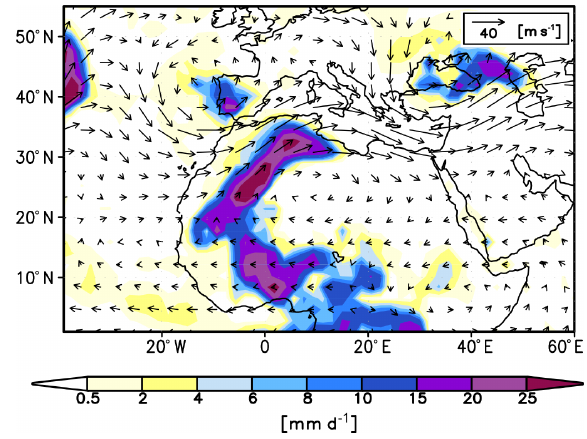
Figure 6. Example of a strong rain event of 1d in October in the Sahara at 7ka: shown are the upper tropospheric wind (300hPa, vectors, ms − 1 ) and the daily mean precipitation (mmd − 1 ).